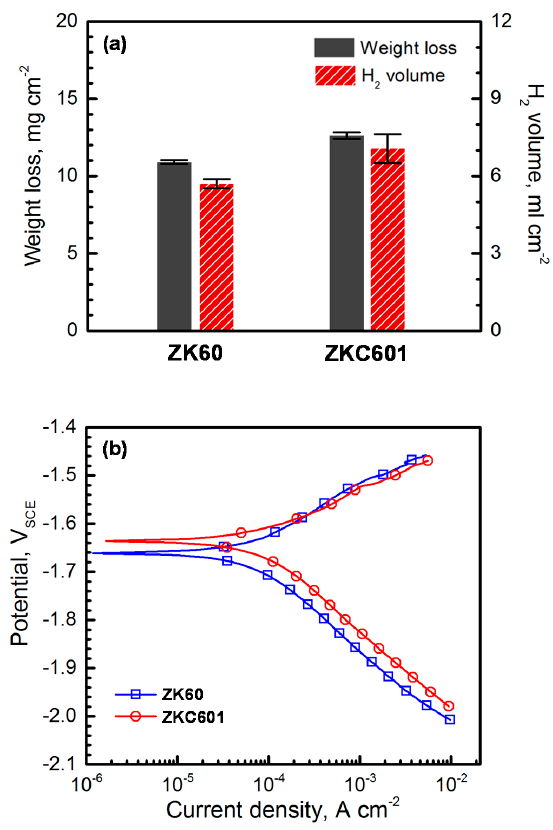
Figure 3. ( a ) Values of weight loss and collected H 2 volume after immersion for 72 h in 0.6 M NaCl solution and ( b ) potentiodynamic polarization curves of the ZK60 and ZKC601 alloys.